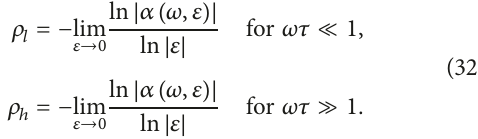
The critical exponents for the function 𝛼(𝜔, 𝜀) are defined, respectively,